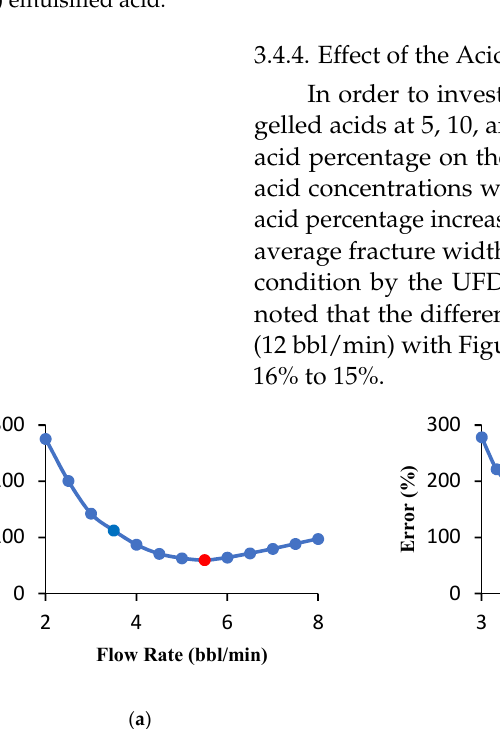
Figure 15. Results of acid volume optimization for three acid systems types. ( a ) straight acid, ( b ) gelled acid, and ( c ) emulsified acid.